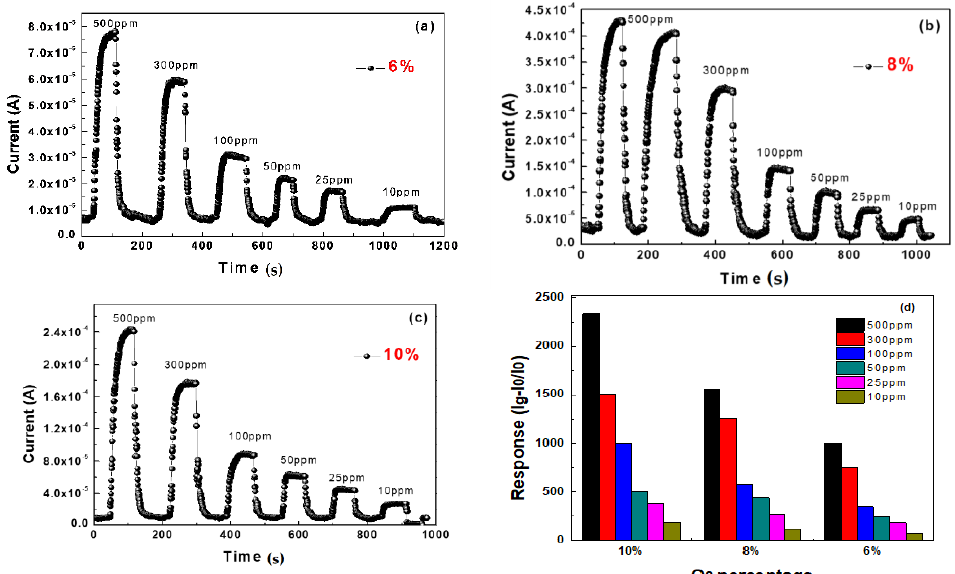
Figure 3. Sensing transients to ethanol for samples with ( a ) 6%, ( b ) 8%, and ( c ) 10% oxygen flow ratio at 300°C, respectively. ( d ) Variation in sensitivity with ethanol gas concentration.